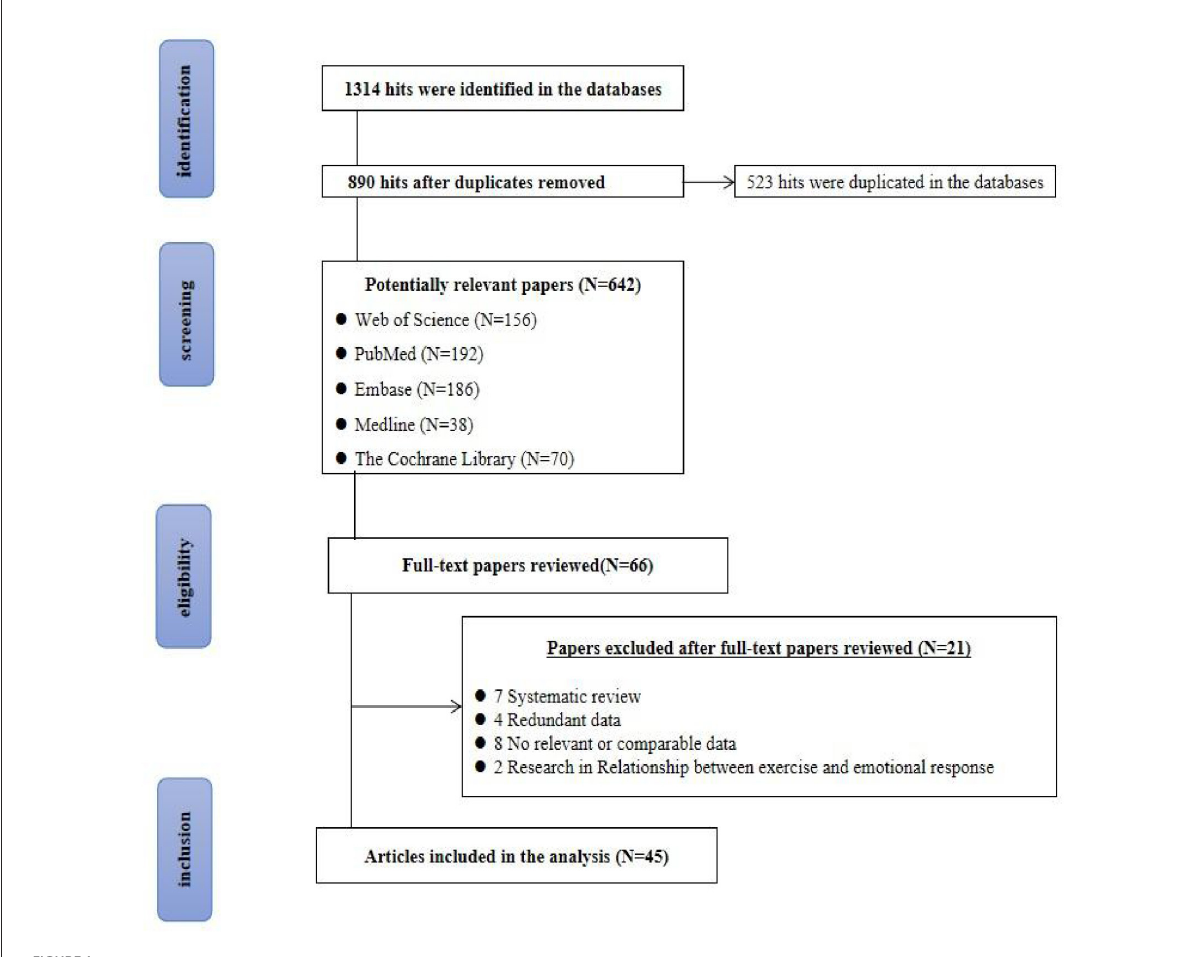
FIGURE1 PRISMA flow